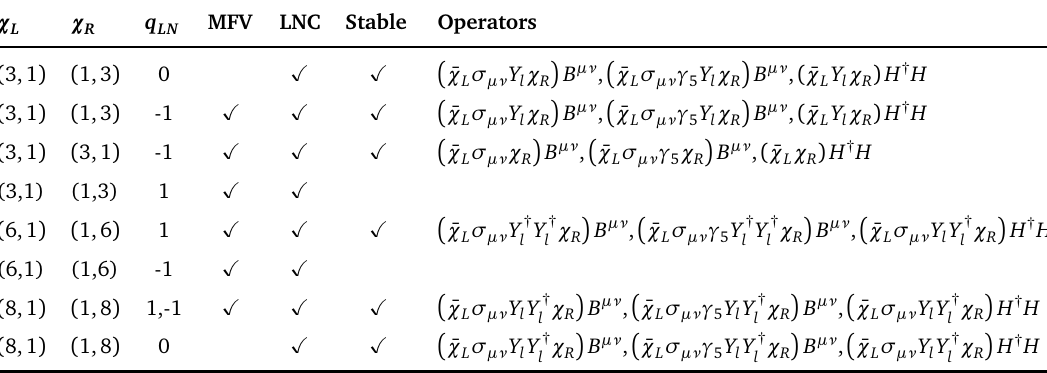
Table 1: Shown are the lowest dimension flavor representations. The columns are, re- spectively, representation of χ MFV requirement is essential to the stability argument, whether lepton number con- servation (LNC) is imposed, whether χ is stable, and the lowest dimension operators allowed under